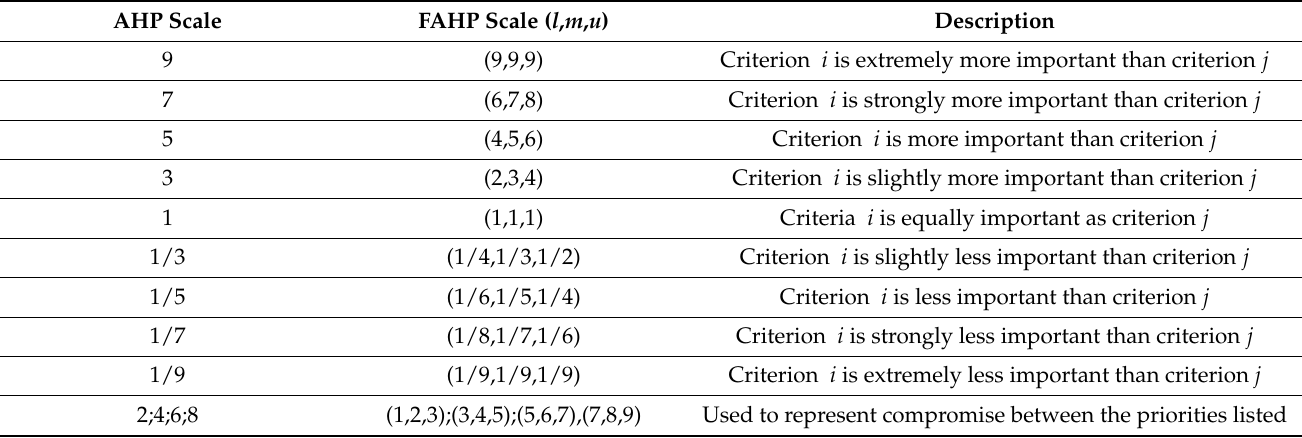
Table 1. The scales for pairwise comparison by AHP and